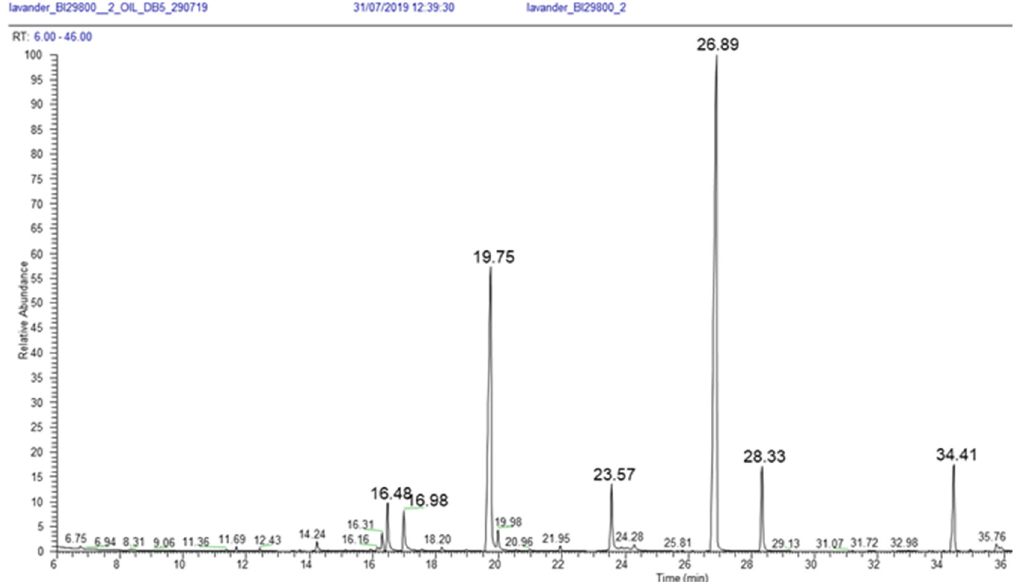
Figure 15. Gas chromatogram produced in gas chromatography, using a mass spectrometer for peak detection of a sample of lavender oil.